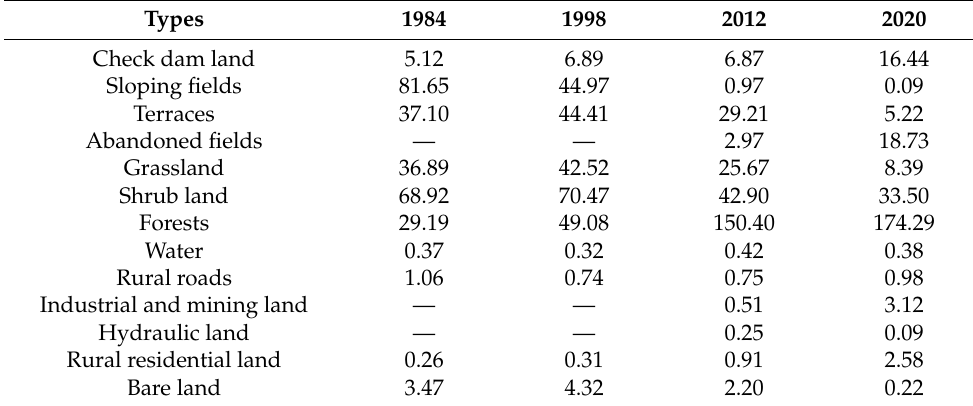
Table 4. Area of land use types in the study area from1984 to 2020